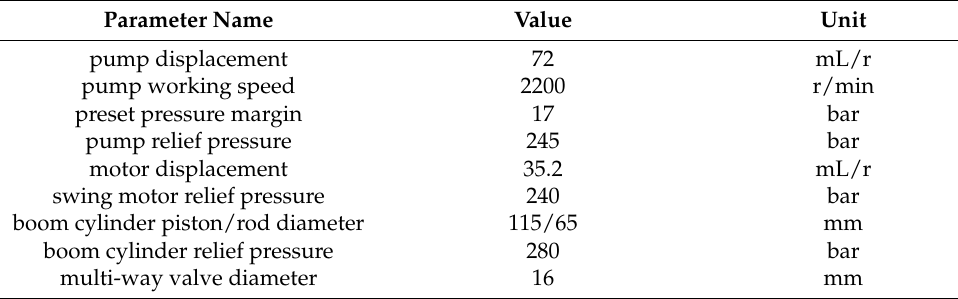
Table 1. Parameters of hydraulic components.